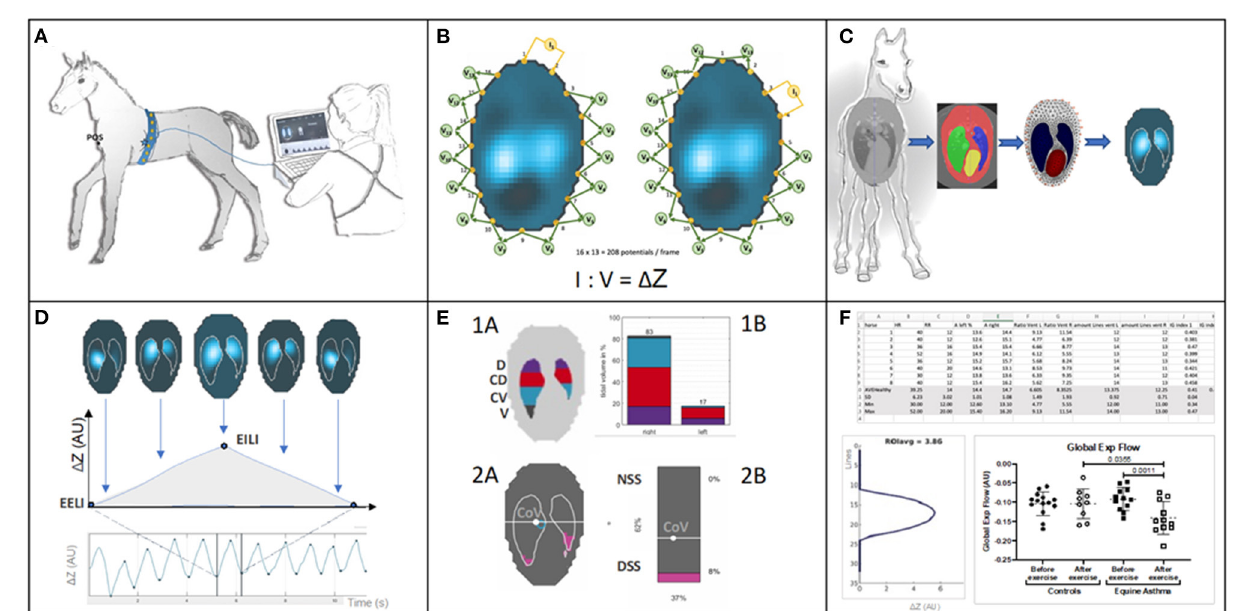
FIGURE 1 | (A) Belt placement: Electrodes mounted on a custom-made stretchable belt are applied around the thorax of a foal. The belt is directly connected to the EIT device and from there to a stall side monitor screen, on which the generated EIT images are displayed in real-time. (B) Measurement principle: The EIT system applies known non-perceivable alternating current (usually between 50 and 250kHz and an amplitude < 10mA) across a pair of “driving” electrodes and reads the voltage at the remaining electrode pairs allowing impedance calculation. The “driving” electrode pair then switches to the next set, with voltages again being measured. This continues until all pairs of electrodes have been “driven.” Based on all impedance calculations one frame is created. EIT data is constructed from these frames, usually at a rate of 50 frames per second, but this can be varied. (C) Application of a finite element model or mesh: To illustrate thoracic impedance changes during ventilation, images are reconstructed using a species-specific finite element model. The model is obtained from a species-specific computerised tomography image which provides anatomical information and definition of lung regions. (D) EIT images and waveforms: Breath related impedance change ( 1 Z, y-axis) between impedance at the start of inspiration (end-expiratory lung impedance; EELI) and maximal impedance at the end of inspiration (end-inspiratory lung impedance; EILI) during respiratory cycles over time (x-axis). The image represents the impedance change between EELI and EILI. (E) Functional EIT images and examples of possible EIT variables: Top: 1A Thoracic image of the EIT derived variables include the 8 regions of ventilation. The eight regions are derived from anatomical sides within the lung parenchyma right (R), left (L), and anatomical region dorsal (D), centro-dorsal (CD), centro-ventral (CV), ventral (V) within each side. 1B The same variables represented in a bar graph illustrating division of ventilation within these regions. Bottom: 2A Thoracic image of additional EIT variables describing: centre of ventilation (CoV) and its vertical and horizontal orientation within the finite element model and the non-dependent (NSS) and dependent (DSS) silent spaces depicted by pink shading (taken from ibex, Sentec, Switzerland). 2B A bar chart representing the preceding variables in percent (%). (F) EIT measures and analysis of variables: examples of numeric output of variables and graphical illustration of results after further processing for off-line